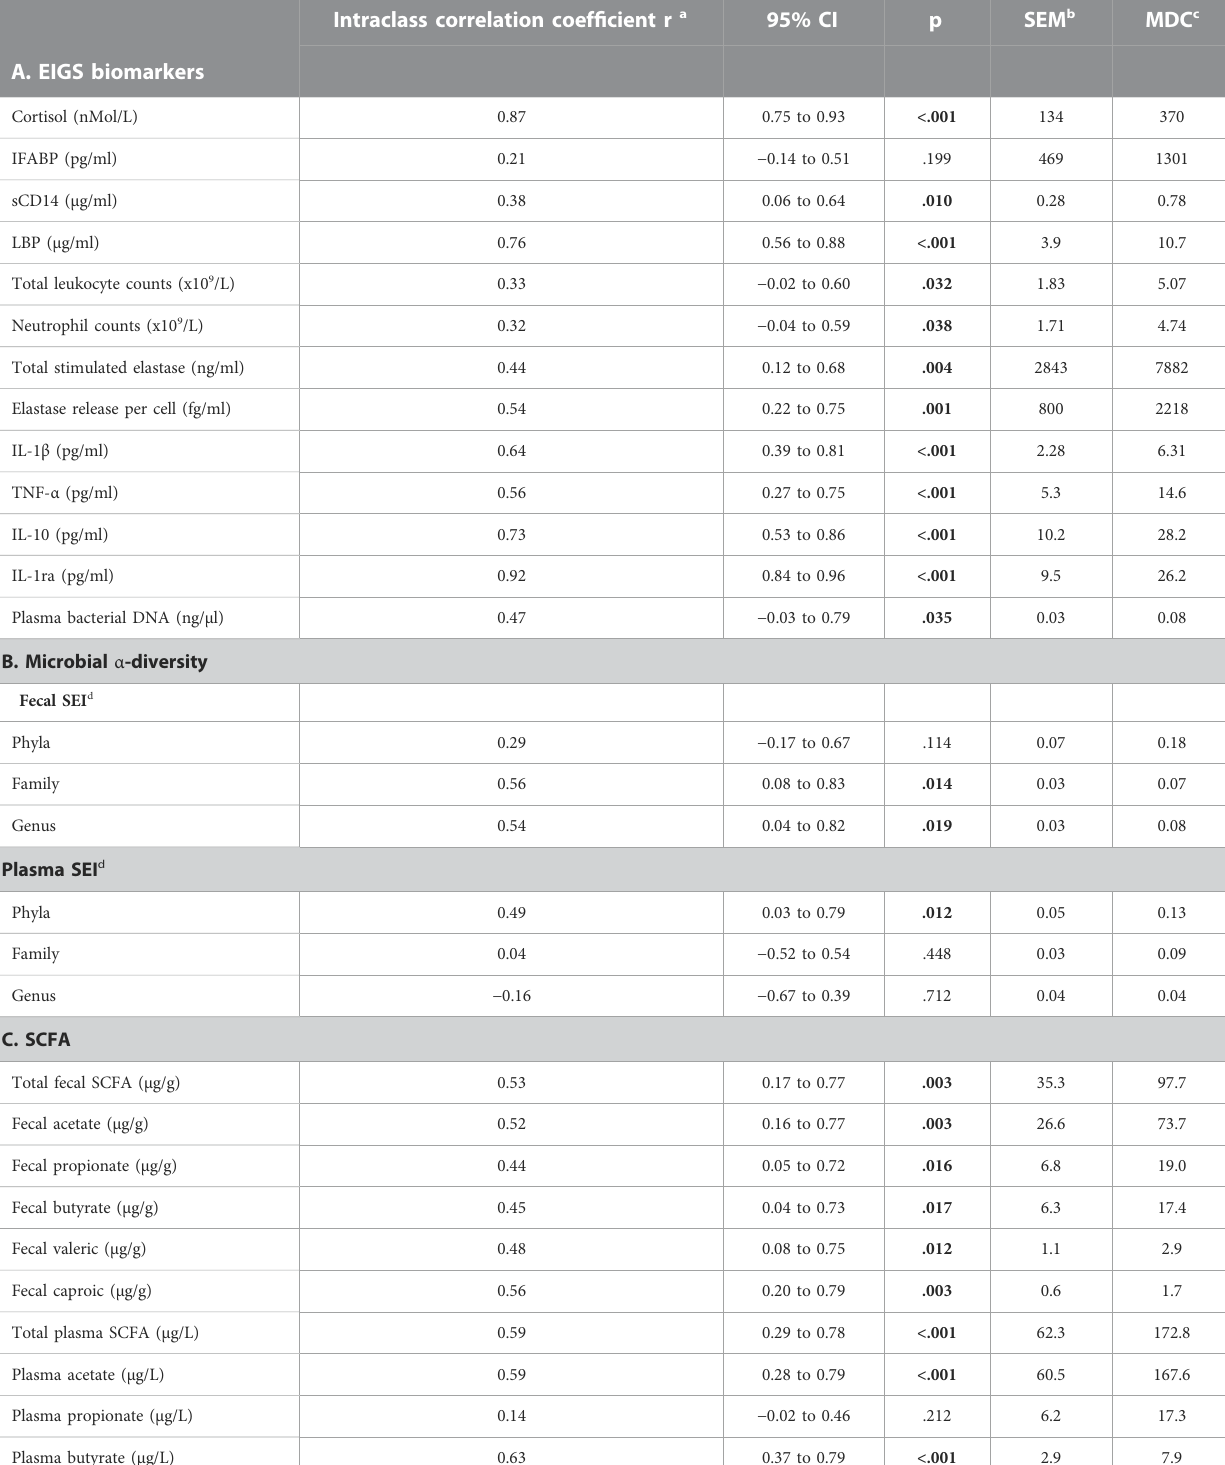
TABLE4Reliabilityindicesofpre-exerciserestingexercise-inducedgastrointestinalsyndrome(EIGS)biomarkers(A),plusfecalandplasmamicrobial α -diversity(B) and short chain fatty acid (SCFA) concentrations (C) between Trial-1 and